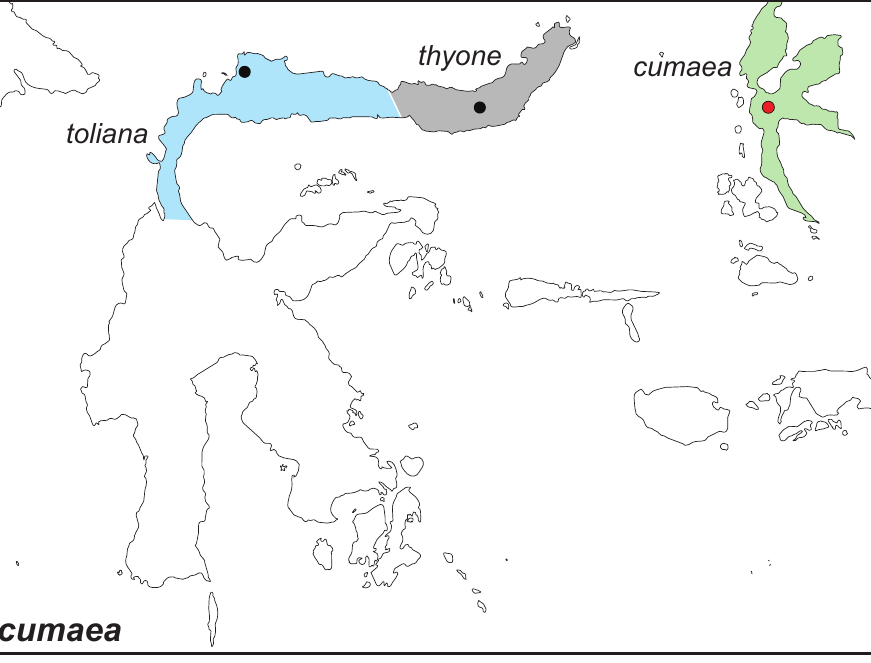
Figure 68. Distribution map of Elymnias cumaea